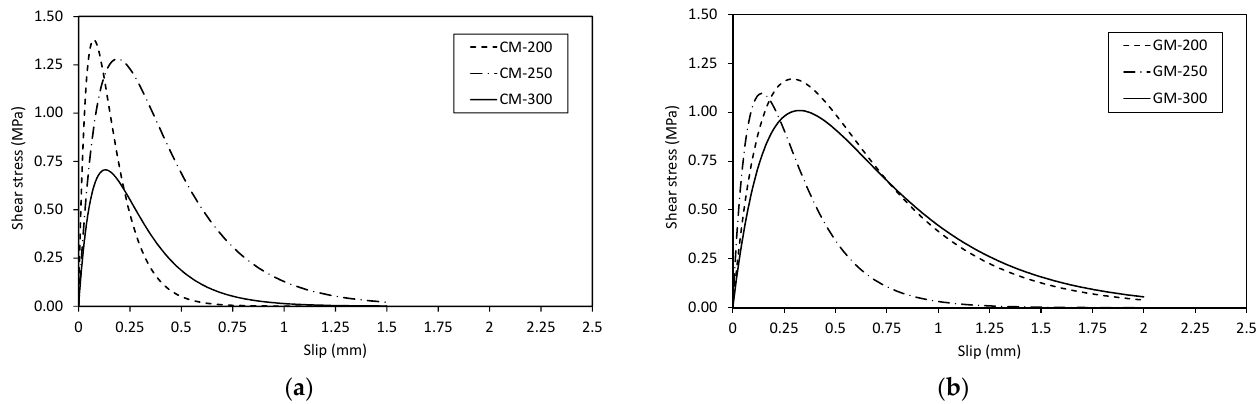
Figure 9. Shear stress-slip relationships for the tested specimens with l b > l eff : ( a ) Cementitious-matrix specimens, ( b ) Geopolymeric-matrix specimens. Table 4. Parameters of the bond-slip models.